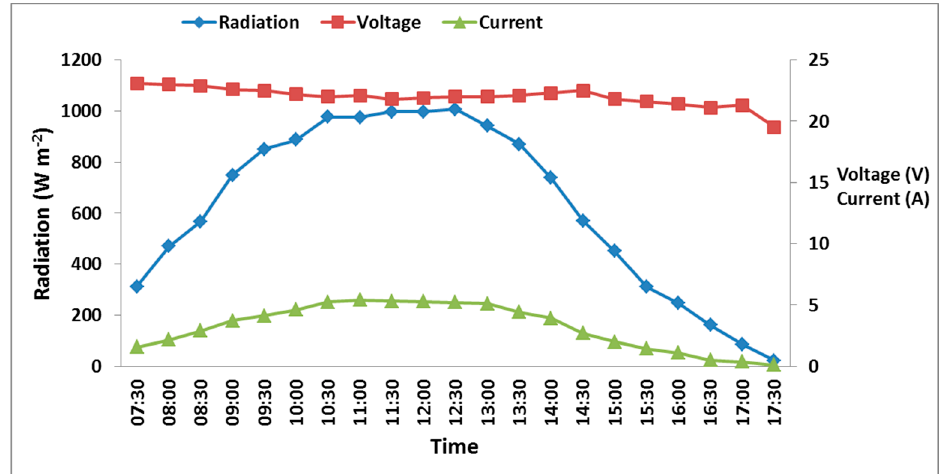
Figure 6. Measured irradiance and both voltage and current produced from the solar panel over daytime.